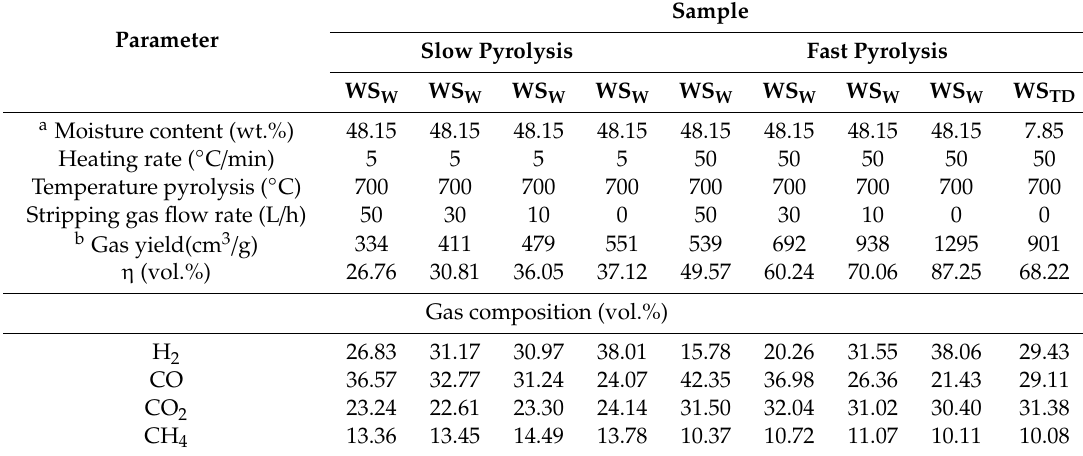
Figure 8. Effect of the stripping gas flow rate on hydrogen yield under different pyrolysis conditions (slow and fast pyrolysis process). Table 3. The influence of the stripping gas flow rate on the gas yield, conversion efficiency ( η ) and gas composition.